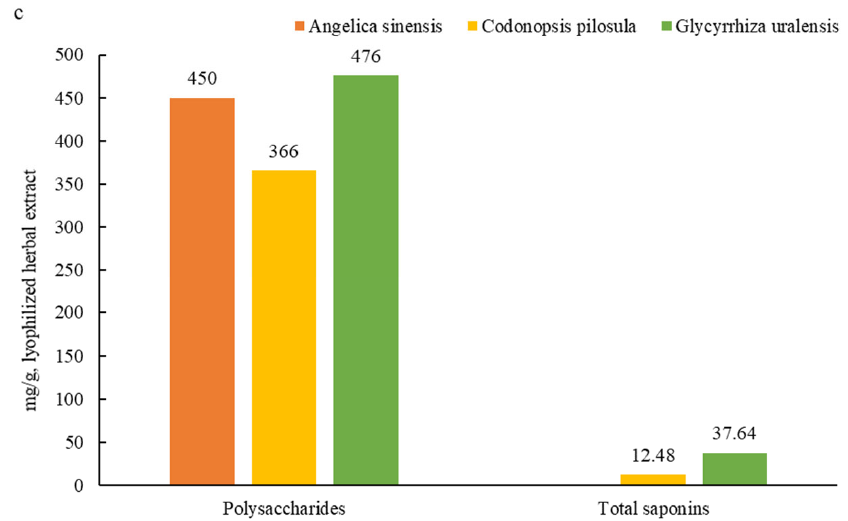
Figure 2. The main components of the three herbal extracts; ( a ), Main components in three herbal extracts detected by UHPLC-QE-MS; ( b ), ligustilide, flavonoids, and terpenoids of three herbal root extracts detected by UHPLC ‐ QE ‐ MS; ( c ), polysaccharides and total saponins ( Angelica sinensis not measured) of three herbal root extracts.